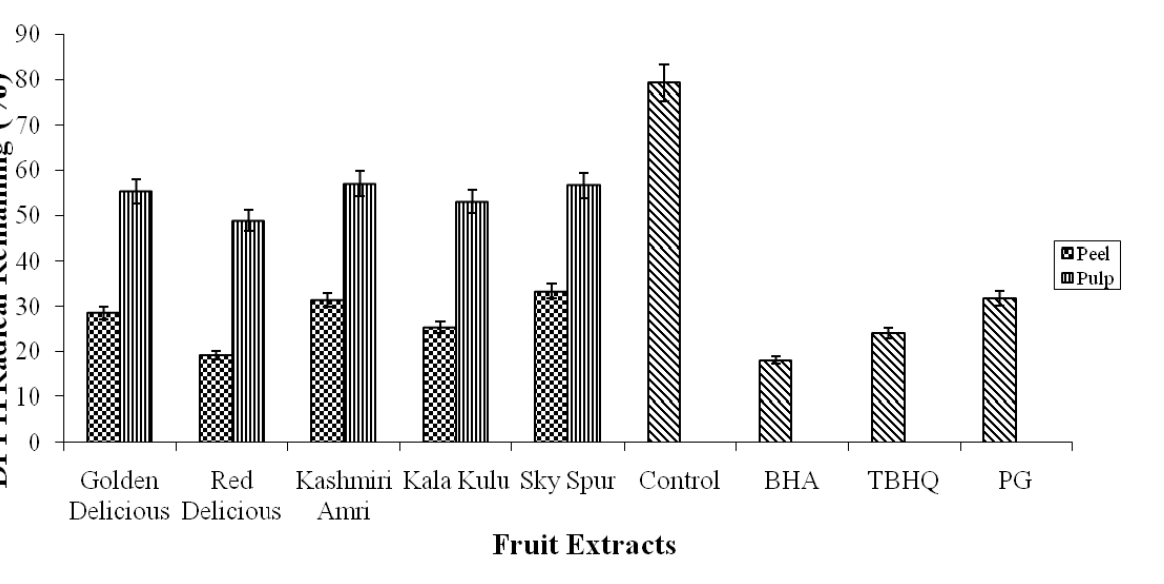
Figure 1. DPPH radical scavenging activity of 80% methanolic extracts of peel and pulp from different cultivars of apple ( Malus domestica Borkh.)